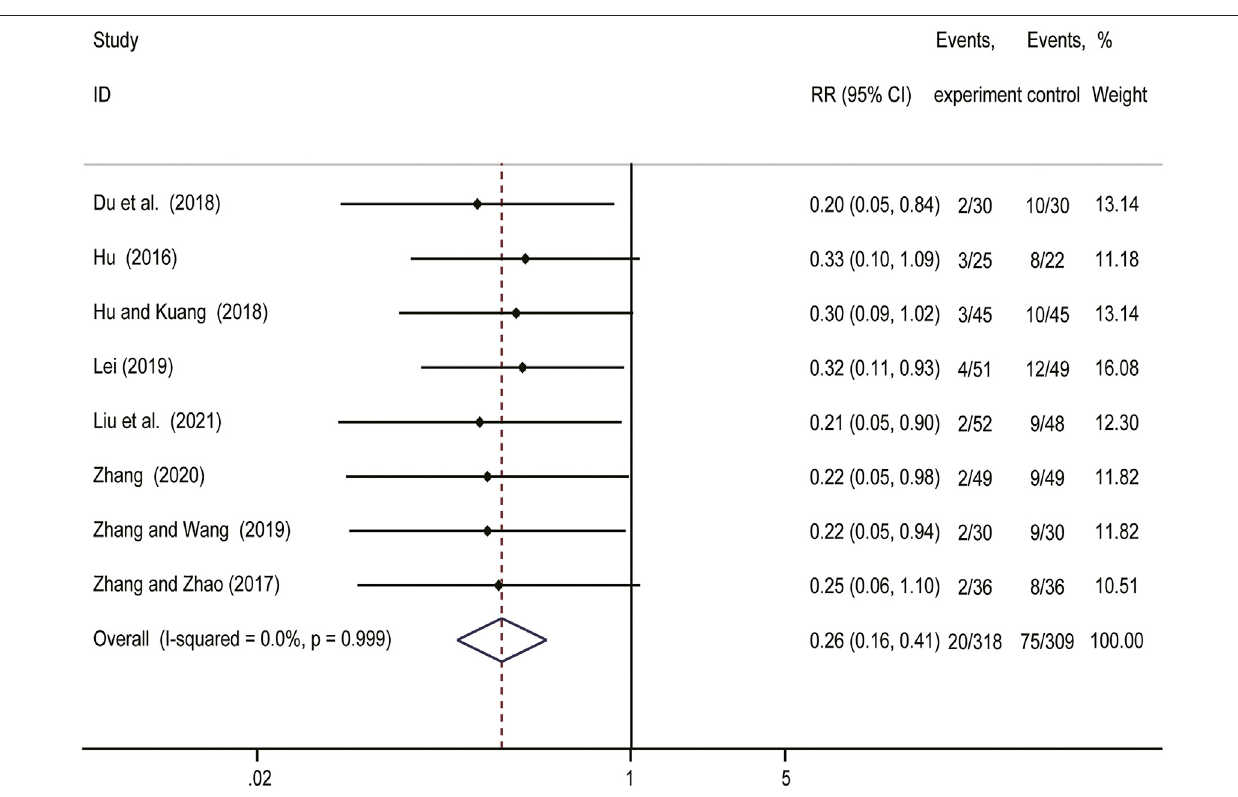
Frontiers in Pharmacology |